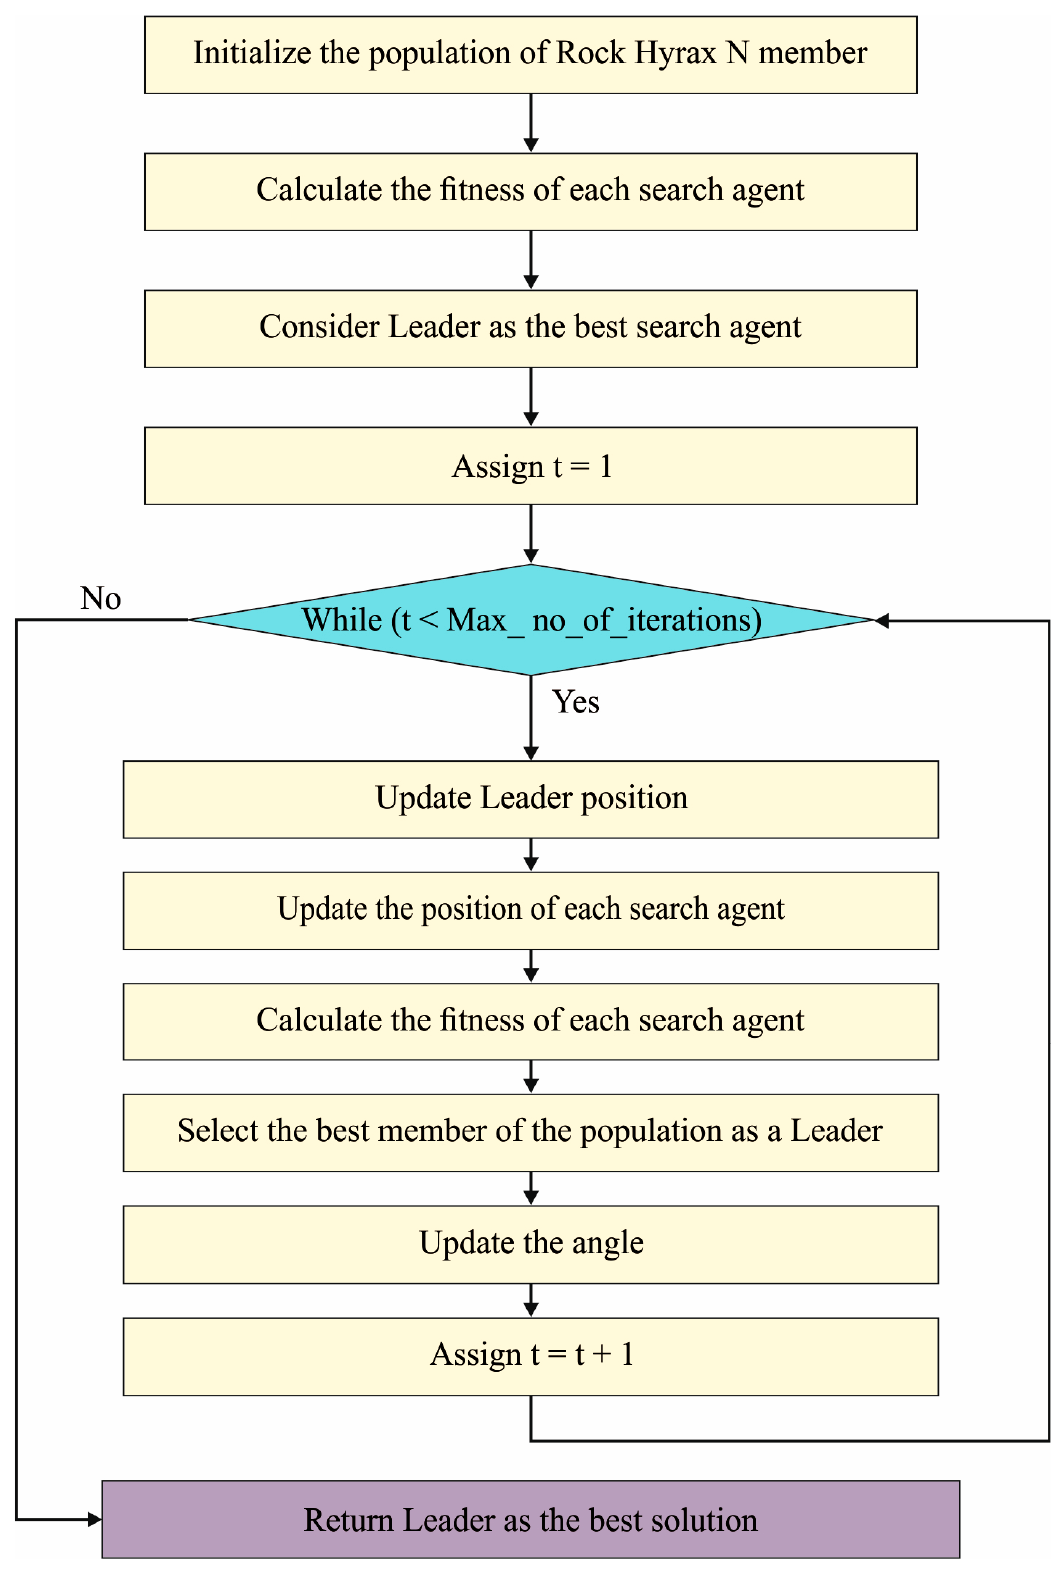
Figure 2. Flowchart of RHSO algorithm.